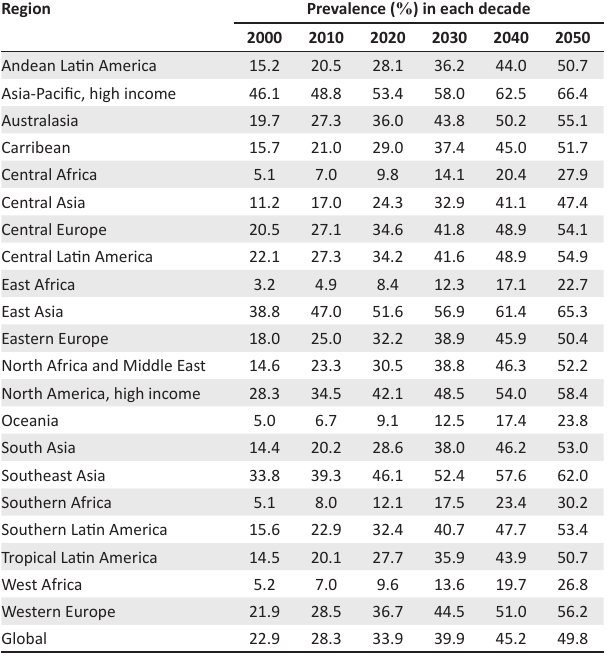
TABLE 1: Estimated prevalence of myopia between 2000 and 2050. Region Prevalence ( % ) in each